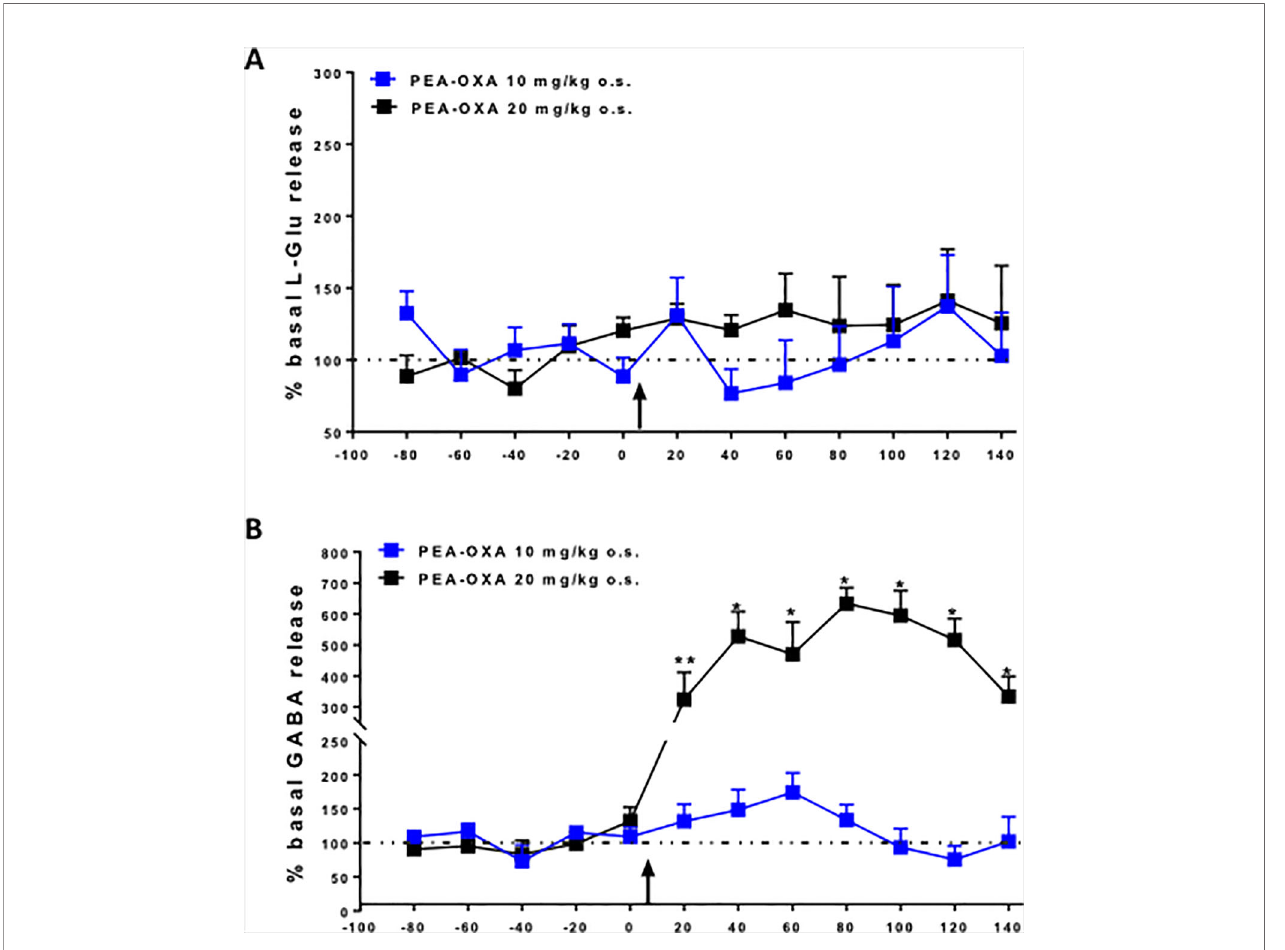
FIGURE 6 | Effects of single injection of PEA-OXA (10 and 20 mg/kg, o.s.) on L-glutamate (A) and GABA (B) extracellular levels in m PFC of Na ϊ ve mice. Each point represents the mean ± S.E.M of 3-4 animals per group. *P < 0.05 and **P < 0.01 indicate signi fi cant differences versus time 0. The black arrow indicates the administration of the drugs. P values < 0.05 were considered statistically signi fi cant. One-Way ANOVA, followed by Dunnett's post hoc test for multiple comparisons test was